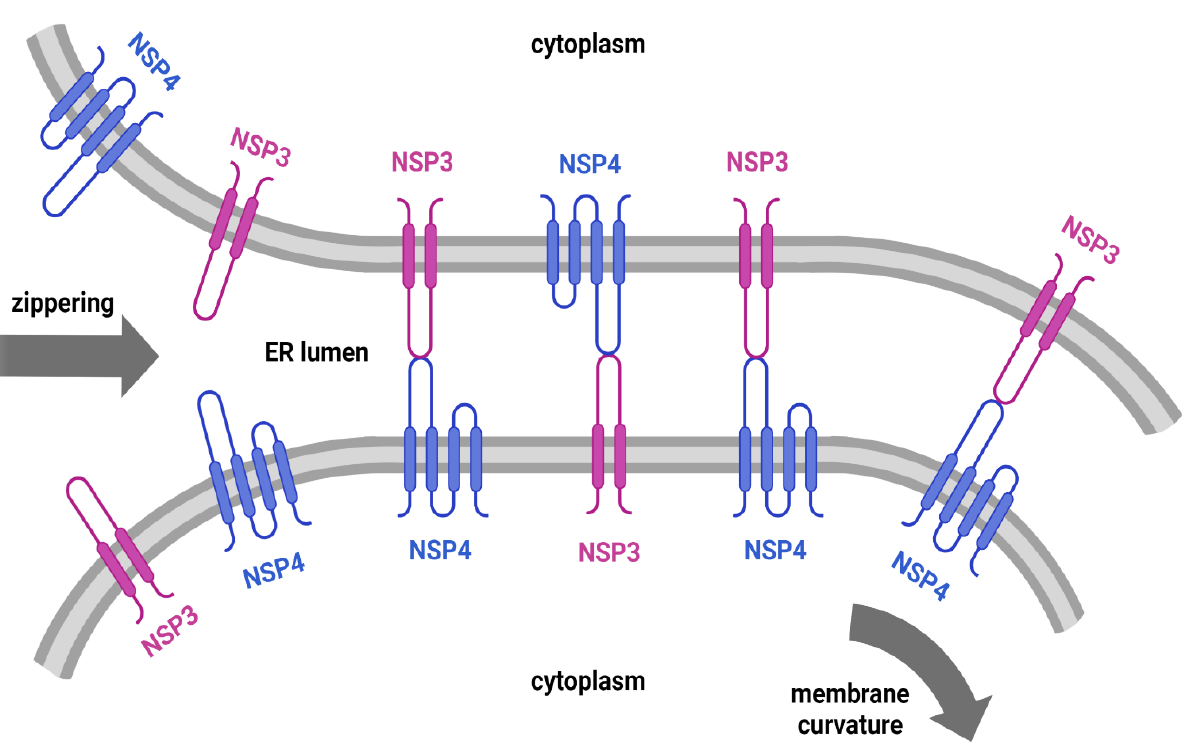
Figure 1. The proposed “ zippering ” mechanism as a model for membrane rearrangements mediated by nsp3 and nsp4. Created with